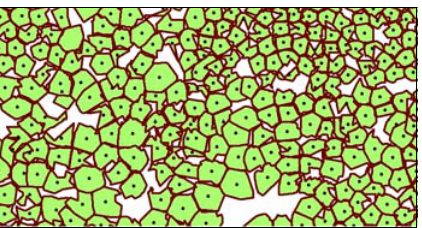
Figure 3. Detected trees and their crowns from ALS data (